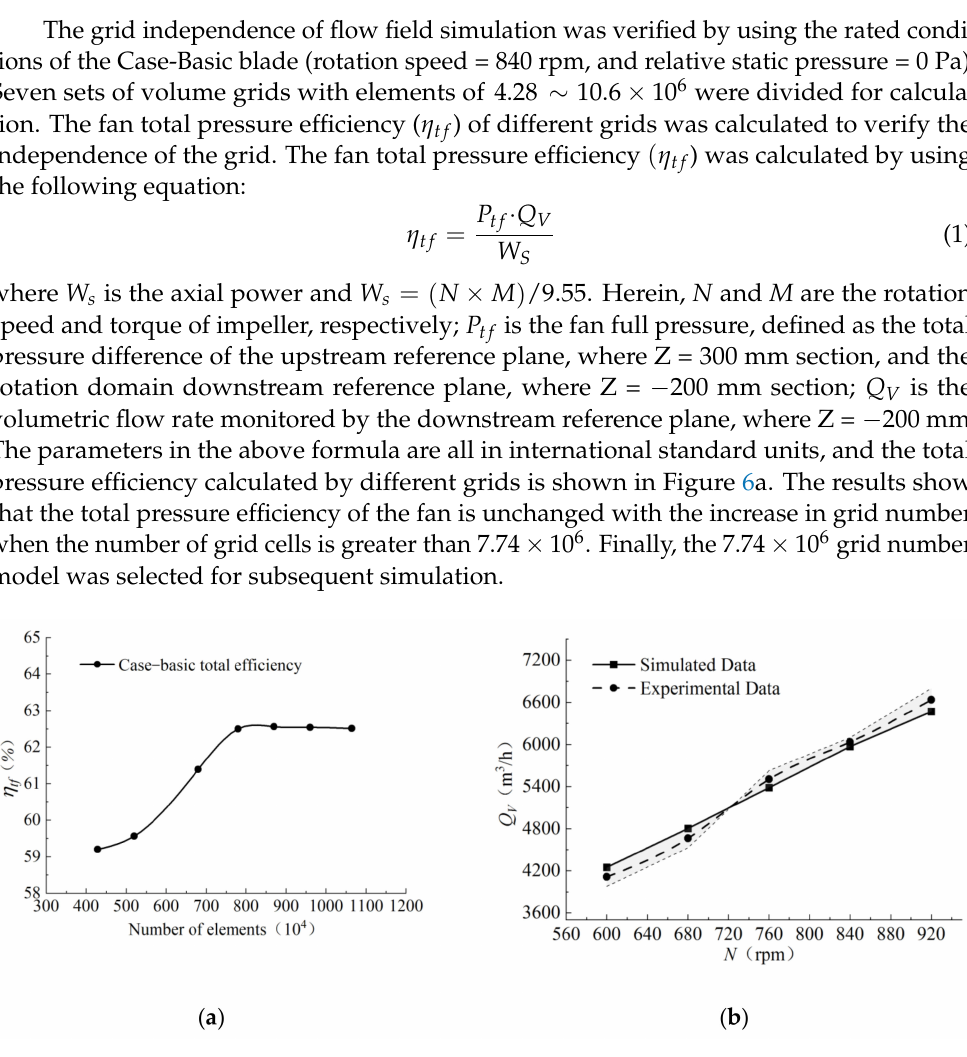
Figure 6. Verification of grid independence and simulation result. ( a ) Verification of grid indepen- dence, ( b ) Verification of simulation